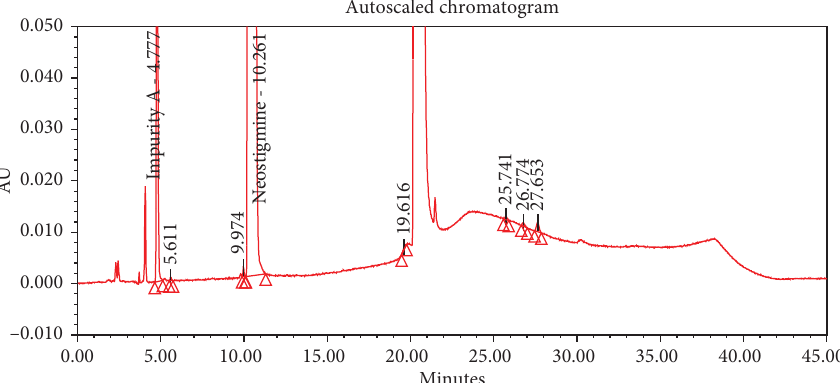
Figure 12: Chromatogram of acid hydrolysis of NMS injection (1mL of 1 N HCl, 60 ° C and for